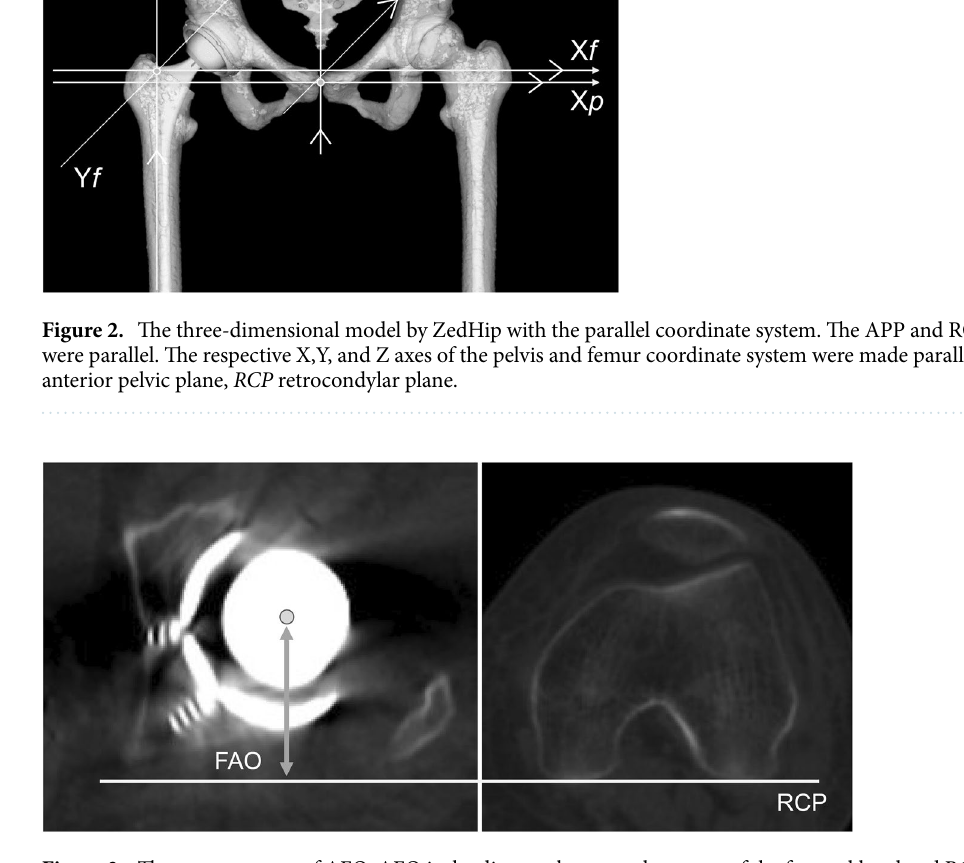
Figure 3. The measurement of AFO. AFO is the distance between the center of the femoral head and RCP in the axial plane. AFO anterior femoral offset, RCP retrocondylar